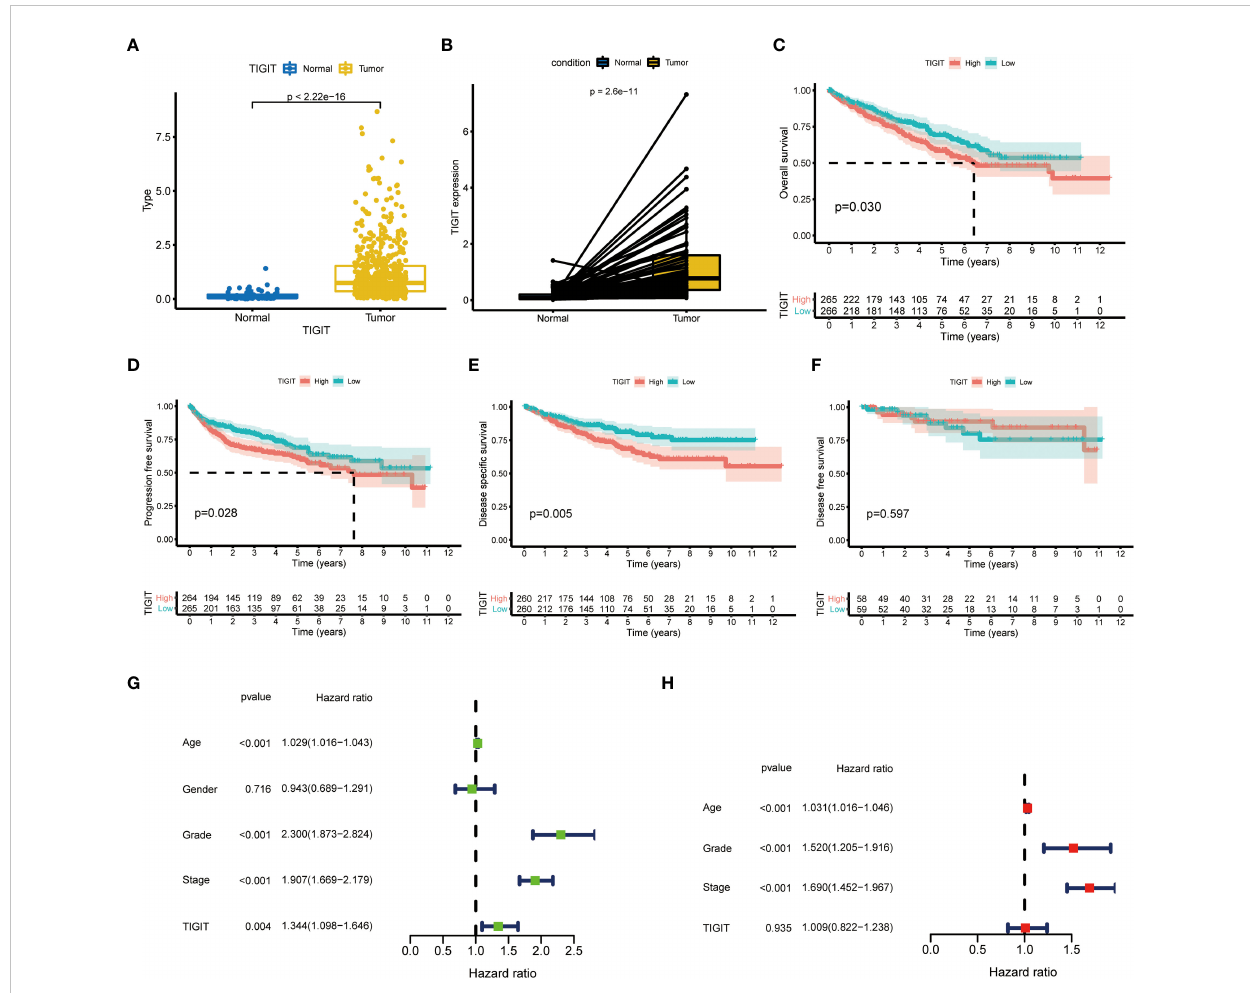
FIGURE 4 Differential expression and prognostic value of TIGIT in KIRC. (A) TIGIT shows a signi fi cantly higher expression in non-paired KIRC tissues compared to the normal tissues. (B) TIGIT shows a signi fi cantly higher expression in paired KIRC tissues compared to the normal tissues. (C) High expression of TIGIT was associated with signi fi cantly poor overall survival in KIRC. (D) High expression of TIGIT was associated with signi fi cantly poor progression- free survival in KIRC. (E) High expression of TIGIT was associated with signi fi cantly poor disease-speci fi c survival in KIRC. (F) There were no signi fi cant differences between patients with high or low expression of TIGIT in disease-free survival in KIRC. (G) Univariate Cox regression showed TIGIT a signi fi cant prognostic factor in KIRC. (H) Multivariate Cox regression of TIGIT in